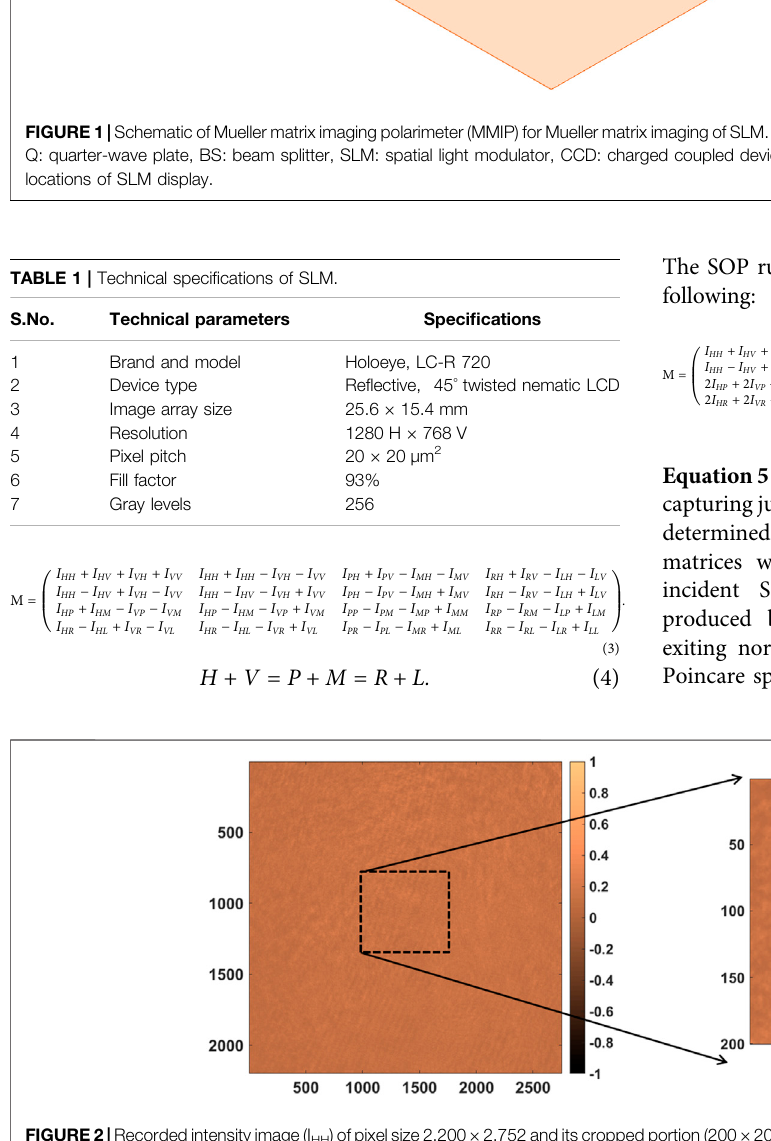
Frontiers in Physics |